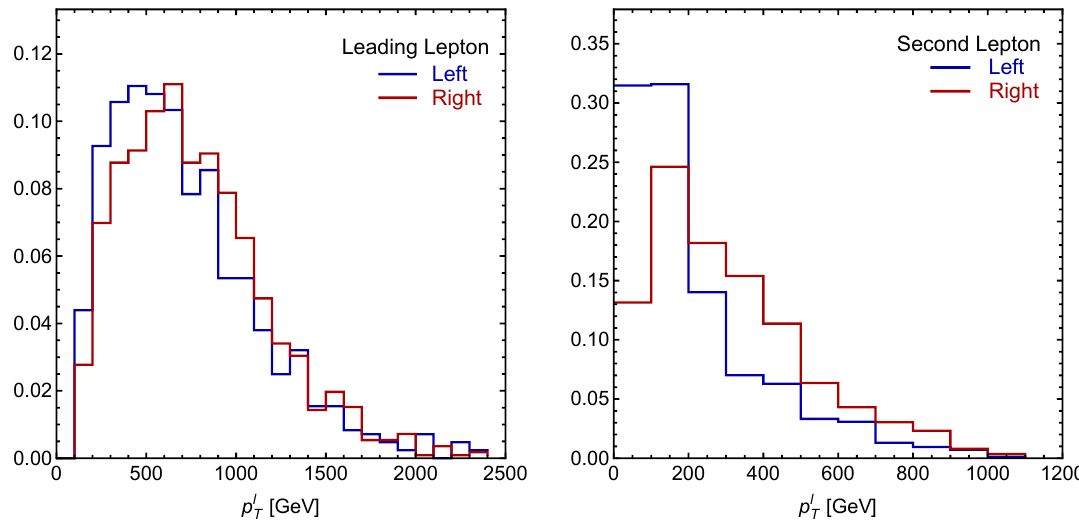
Figure 8 . Detector level shape of the transverse momentum distribution normalised to unit area of the leading (left panel) and subleading (right panel) lepton in the 2SSL channel for left-handed and right-handed X decaying into Wt with m X = 2500 GeV and